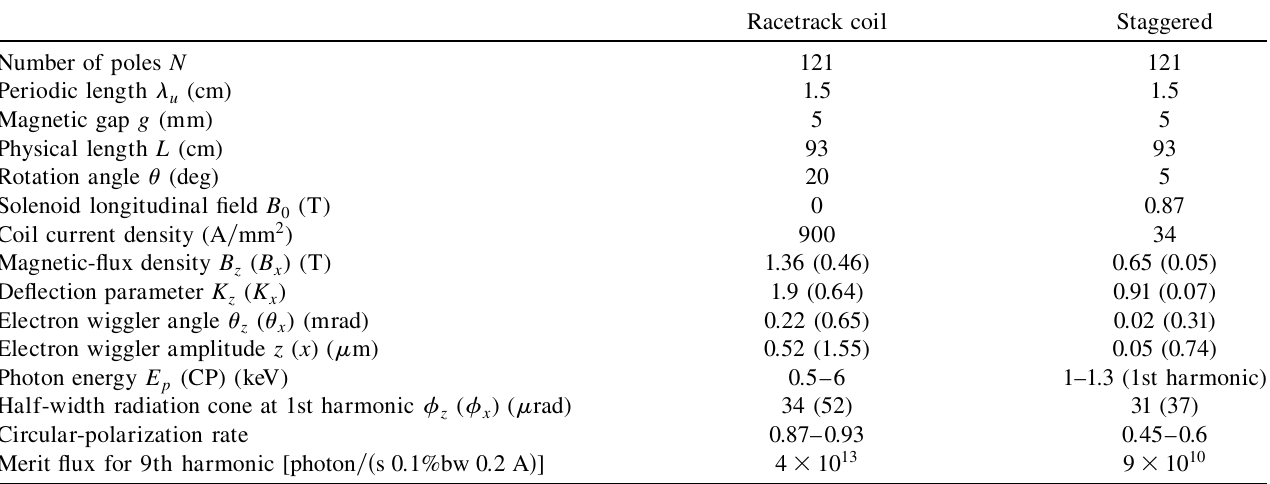
TABLE I. Main spectral features and parameters that govern the design of the superconducting elliptical undulator in the 1.5 GeV storage ring.